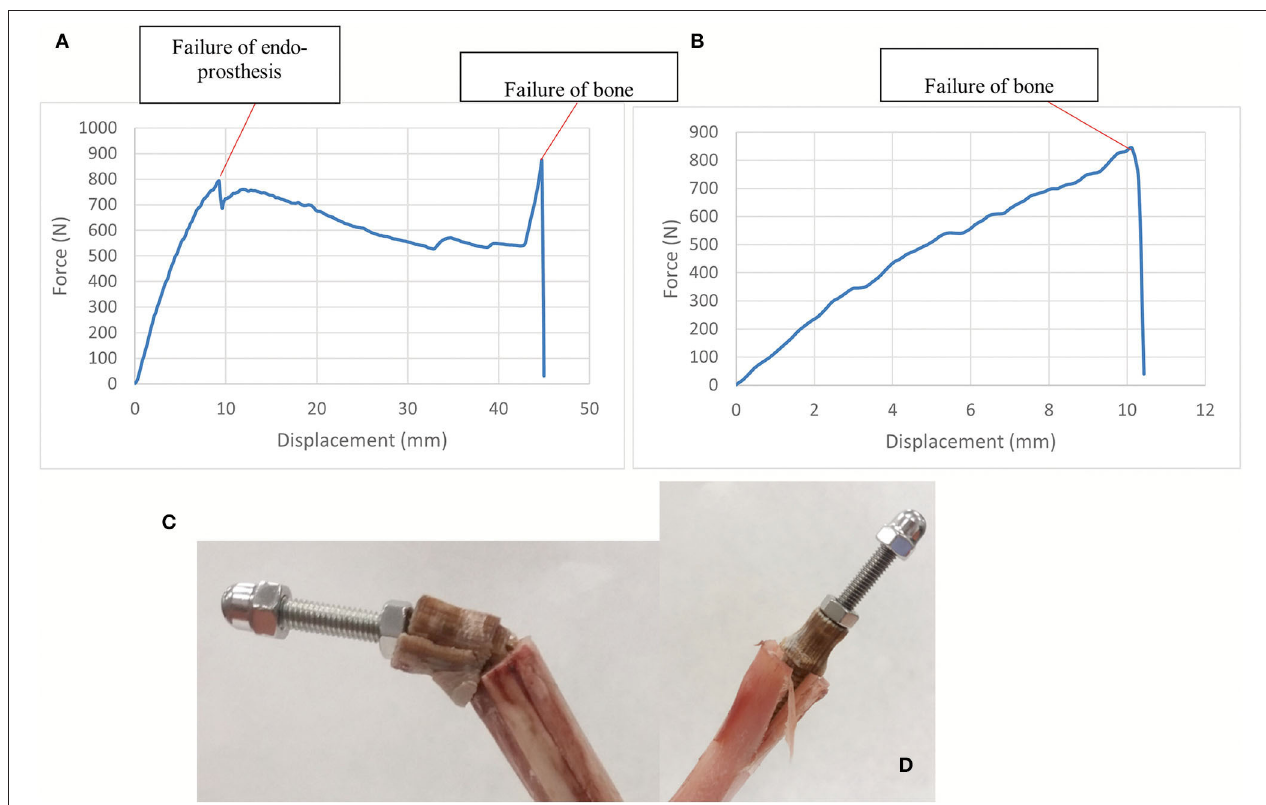
FIGURE 7 | (A,C) show force-displacement curve and ET-samples after endoprosthesis failure in a long tibia. (B,D) show force-displacement curve and ET-samples after bone failure in a short tibia. Compression-bending test of the tibia-endoprosthesis constructs at 67 ◦ to the